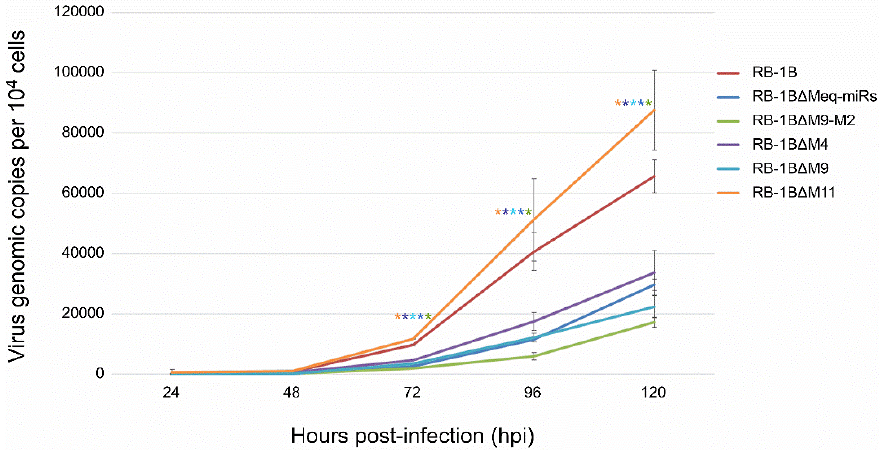
Figure 6. In vitro proliferation of the RB-1B mutant viruses with miRNA-deletions. Viral genomic copies of the parental or mutant viruses per 10 4 cells, estimated based on MDV-1 US2 gene, were determined by a real-time qPCR on DNA from virus-infected CEFs sampled at different time points post-infection. All the experiments were repeated in triplicate. Asterisk (*) indicates statistically significant differences between miR-KO mutant virus and parental RB-1B at different time points. *, p < 0.05.